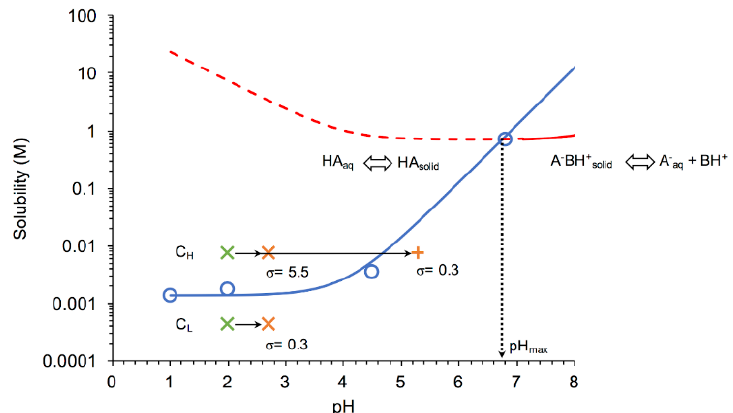
Figure 2. Solubility − pH dependence of free acid and DKT salt indicating the stability regions for salt and free acid solid-state forms and the conditions under which dissolution-precipitation microscopy studies were carried out. Salt has a pH max of 6.7 below which supersaturation with respect to free acid can occur. Two salt concentrations were studied: C L represents the low dose concentration. C H represents a higher concentration of 18x C L , as described in the Materials and Methods section. Arrows represent the pH changes that different salt formulations experienced. Green X represents initial concentration and pH. As the salt dissolves, the bulk pH increased to 2.7 ± 0.2 (orange X) for the bioequivalence (BE) and reference formulation excipients, whereas the pH increased up to 5.3 (orange+) for the non-bioequivalence (non-BE) formulation excipients. Solubility curve for salt (red line) was calculated from Equation (6), using K sp and pK a,DK reported in the text and pK a,T = 8.1 [17]. The free acid solubility curve (blue line) was calculated according to Equation (7). Open circles represent DK measured solubilities at 37 ◦ C. The dashed red line represents supersaturated conditions with respect to DK if solutions are saturated with